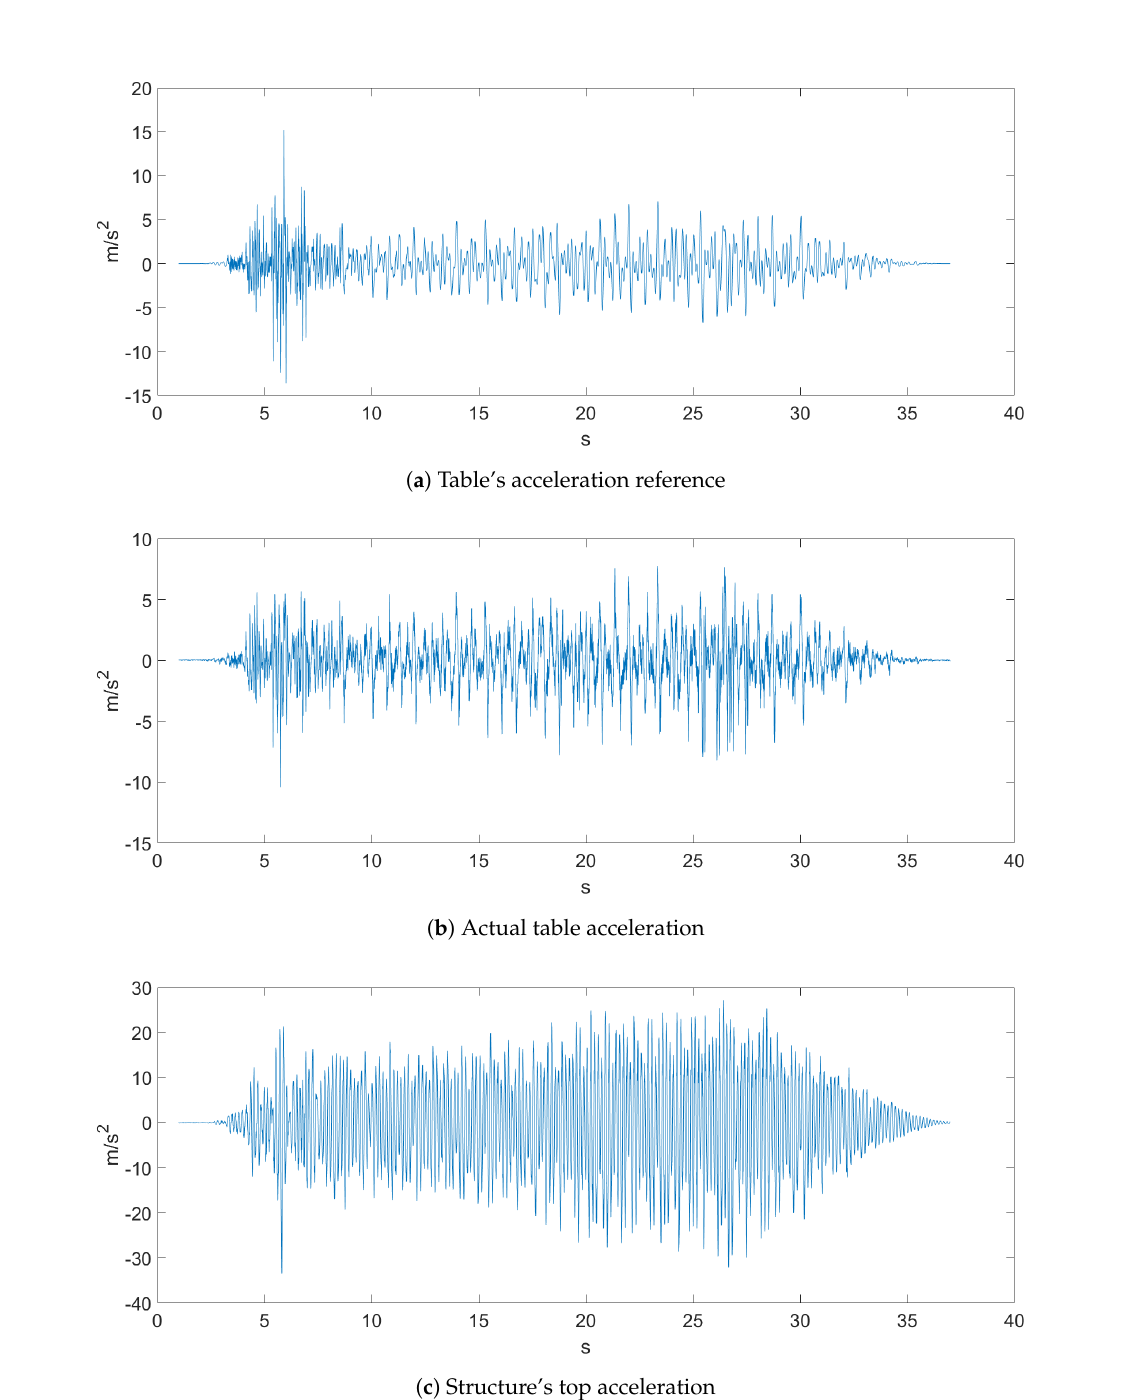
Figure 5. Ground Motion